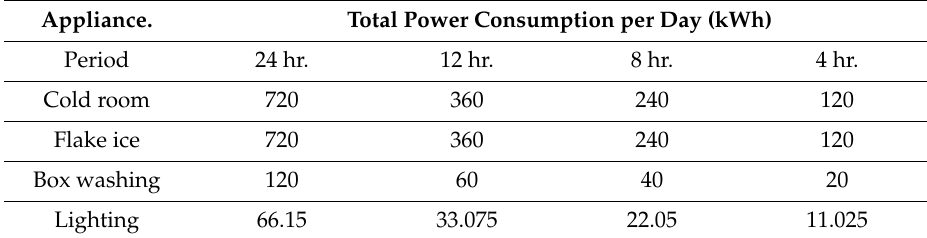
Table 5. Optimum battery size trials for smart energy community.